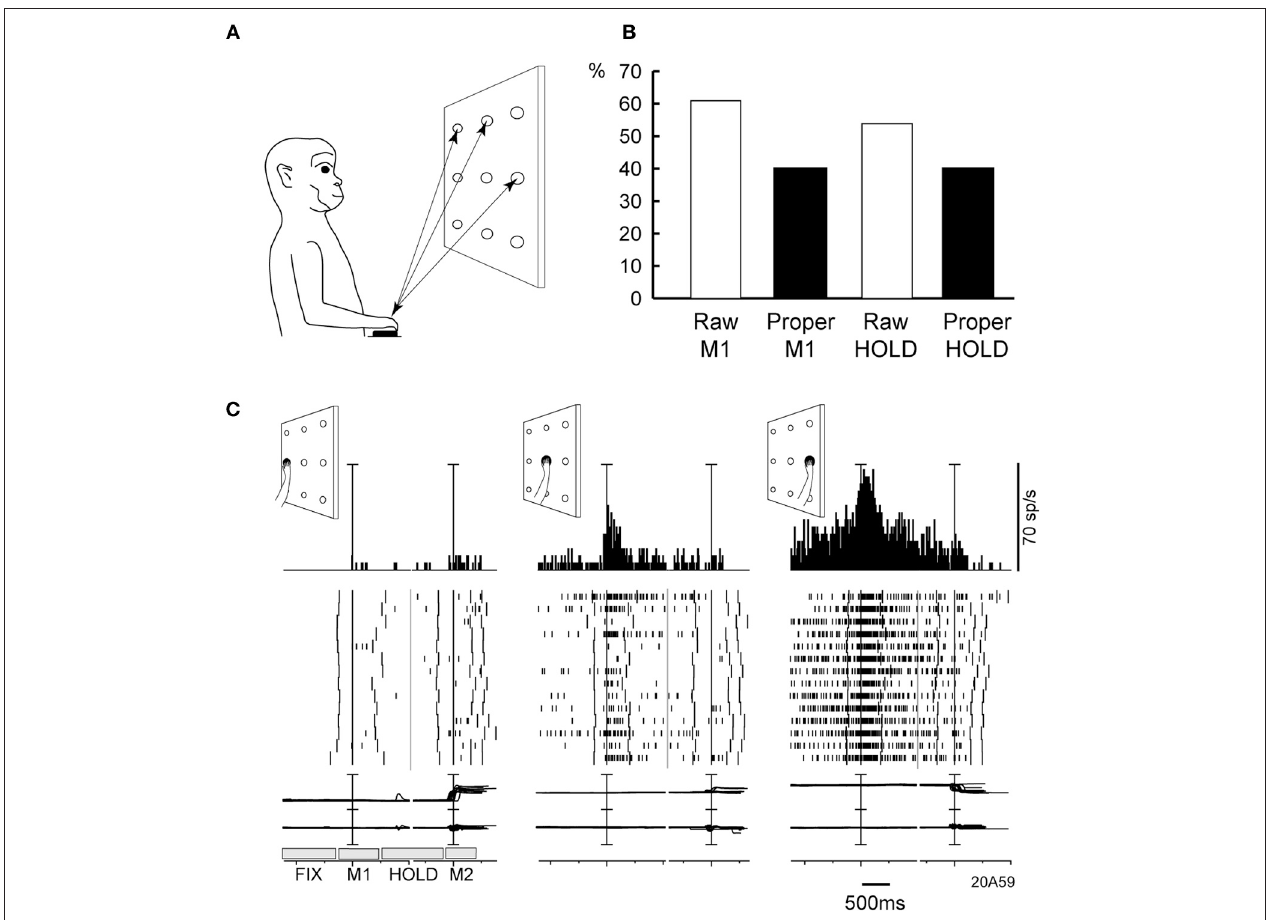
FIGURE 5 | (A) Experimental set-up and time course of a frontal reaching task. Reaching movements were performed in darkness, from a home-button (black rectangle) toward one out of nine targets (open circles) located on a panel in front of the animal. (B) Incidence of V6A cells spatially modulated in the reaching task. Columns indicate the percentages of spatially modulated V6A cells during outward reaching movements (M1), and static position of the arm in the peripersonal space (HOLD). “Proper” activity = “raw” activity – FIX activity. (C) Example of spatially tuned modulation of reach-related activity. Neuron spatially tuned in M1,